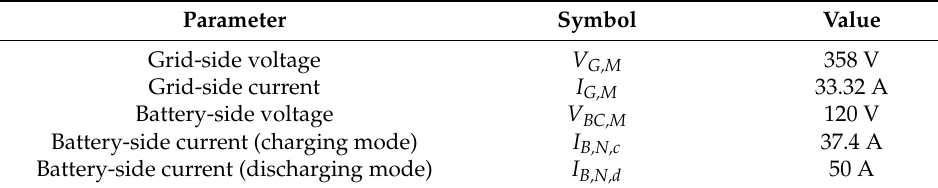
Table 2. Specifications for the grid-side and battery-side BWV2H sizing. Parameter Symbol